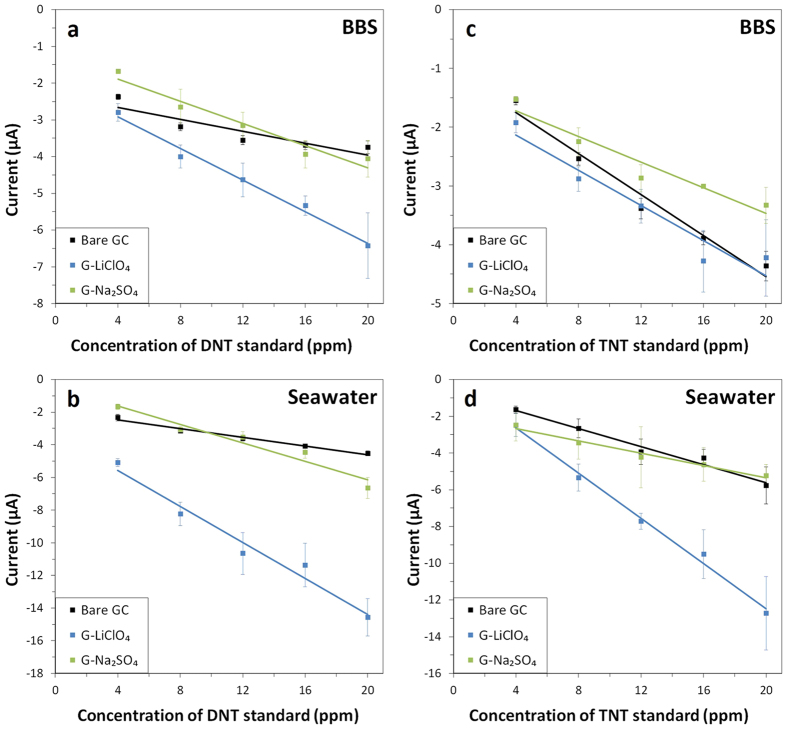
Concentration dependence of DNT (a,b) in (a) BBS and (b) seawater and TNT (c,d) in (c) BBS and (d) seawater at bare GC electrode and GC electrode modified with G-LiClO4 and G-Na2SO4. Conditions: (a,c) BBS (20 mM, pH 9.2) and (b,d) mixture of 9:1 volume ratio of seawater (pH 8.0) to BBS (200 mM, pH 9.2). Data is based on the first reduction peak of DNT and TNT.